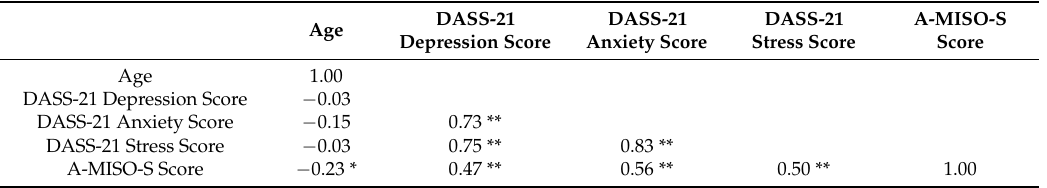
Table 2. Correlation among demographic, clinical, and A-MISO-S variables in patients. Age